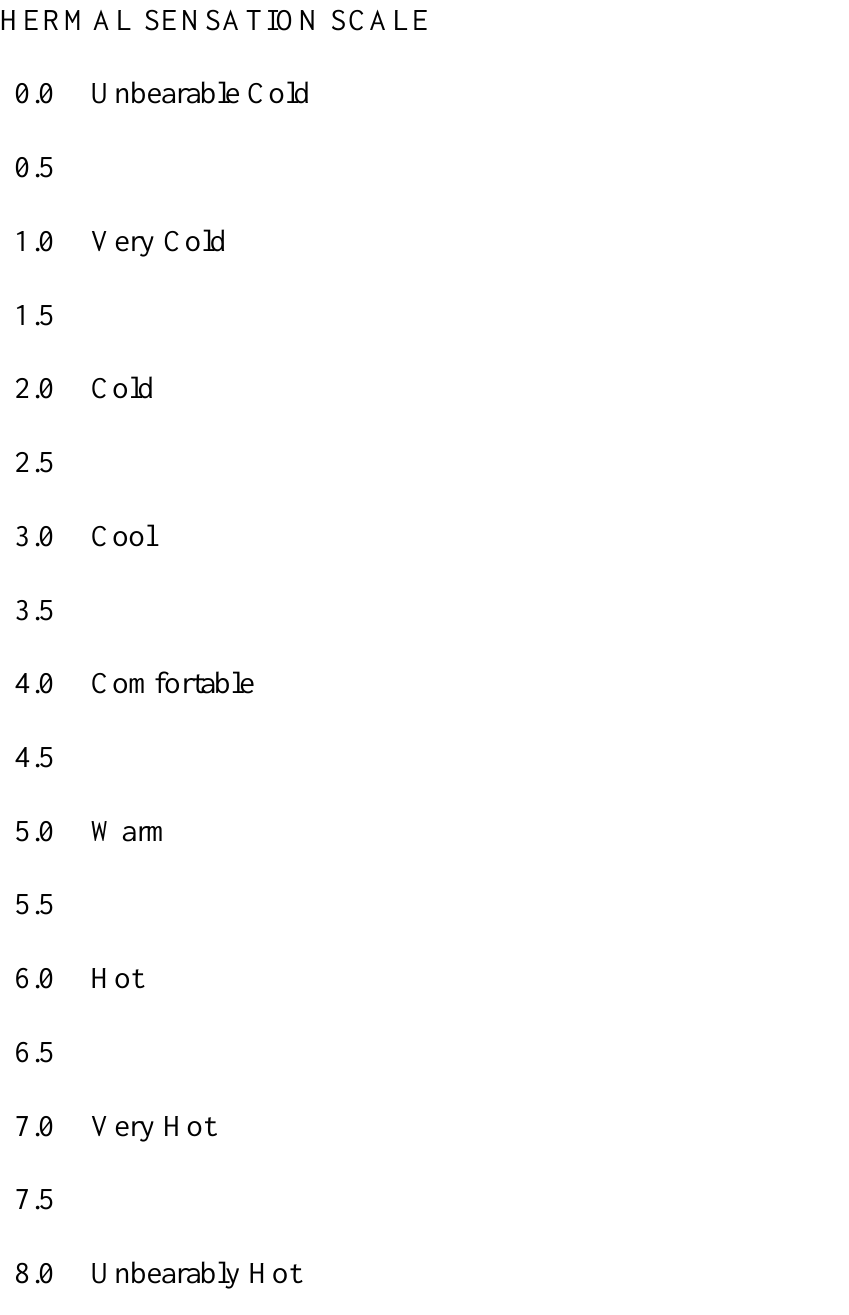
Figure 2. Thermal sensation scale [18].